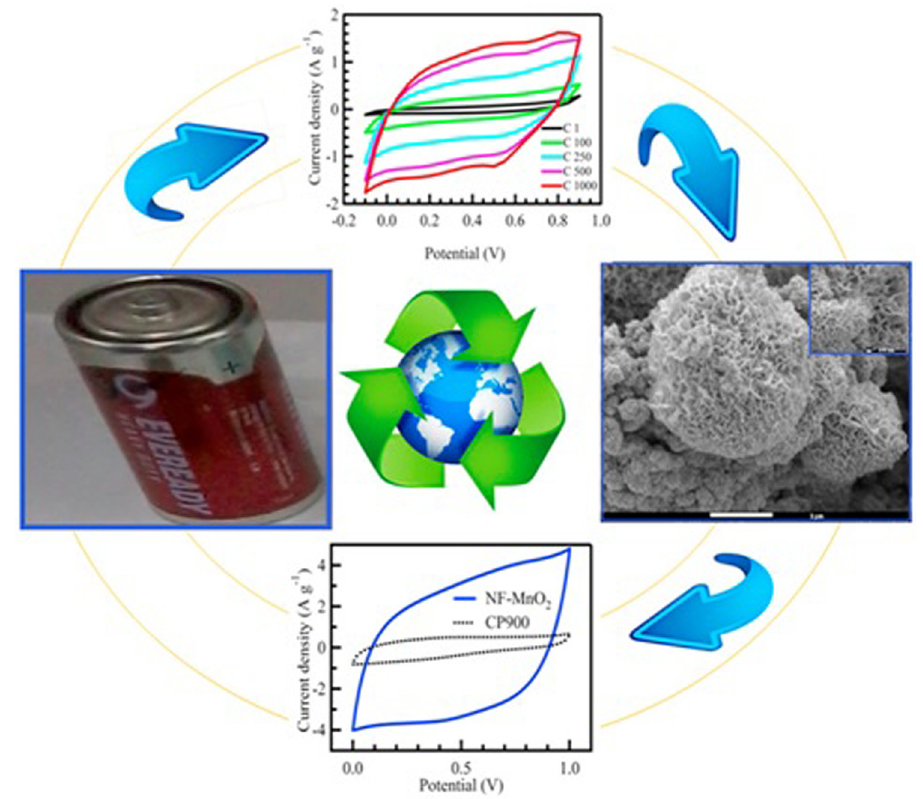
Figure 31: Schematic of the recovery of MnO 2 nano fl owers from a Zn – C battery. Copied with permission from ref. [ 209 ] ; Elsevier,